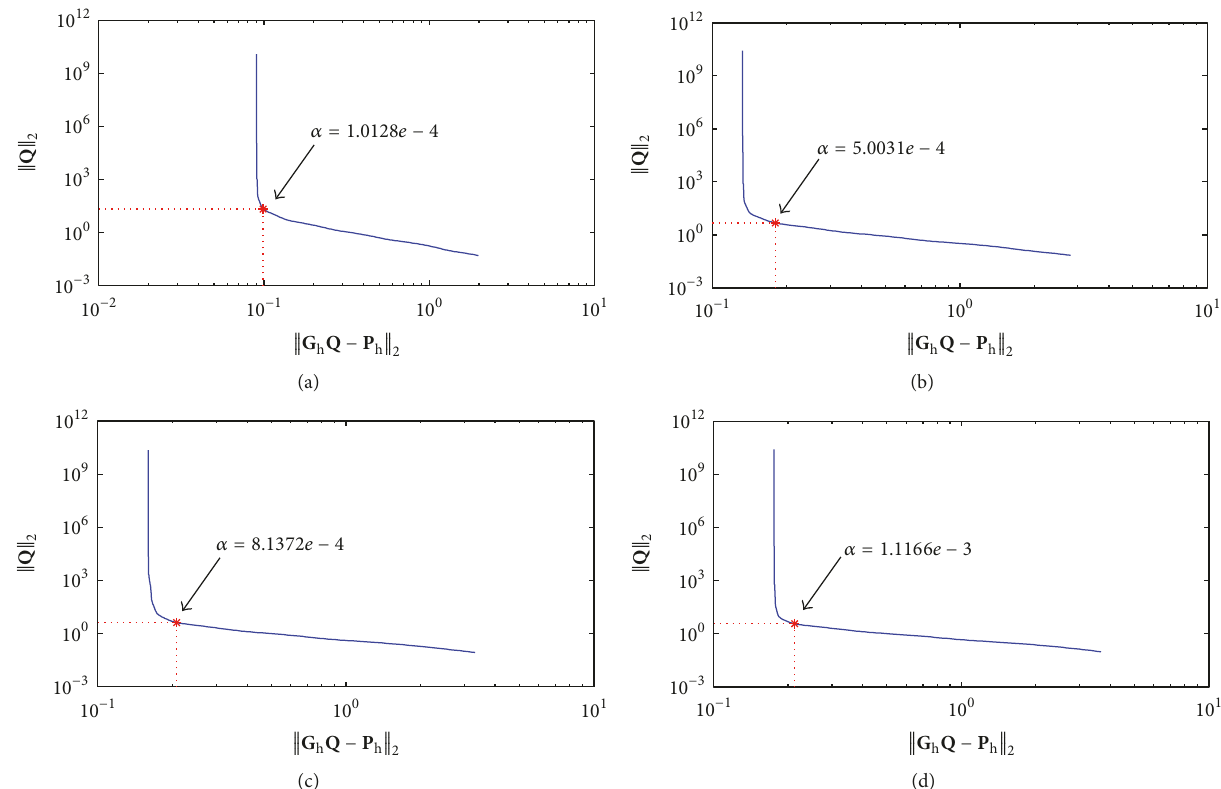
Figure 13: L-Curve of the pressure reconstruction for the pulsating sphere. (a) 300 Hz, (b) 500 Hz, (c) 700 Hz, and (d) 900Hz.